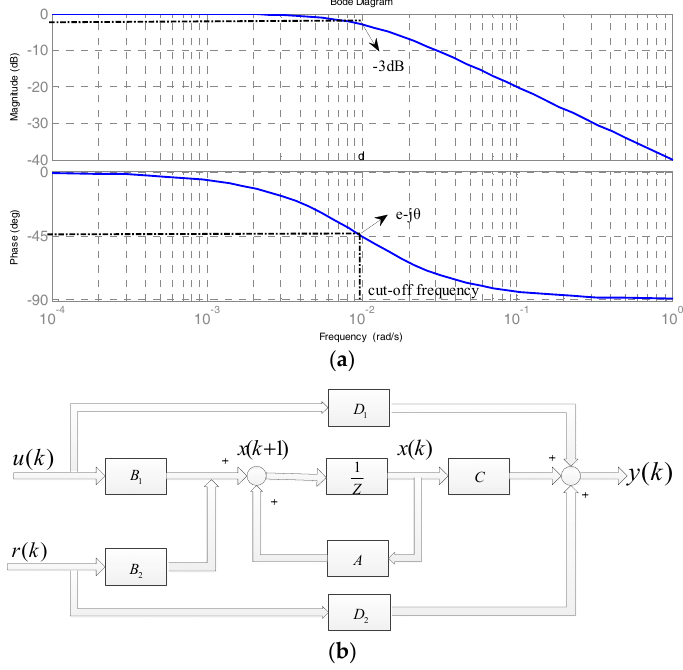
τ ); and ( b ) structure diagram of MPC SSM. Figure 4. ( a ) Bode plot of LFA ( =100 Figure 4. ( a ) Bode plot of LFA ( τ = 100); and ( b ) structure diagram of MPC